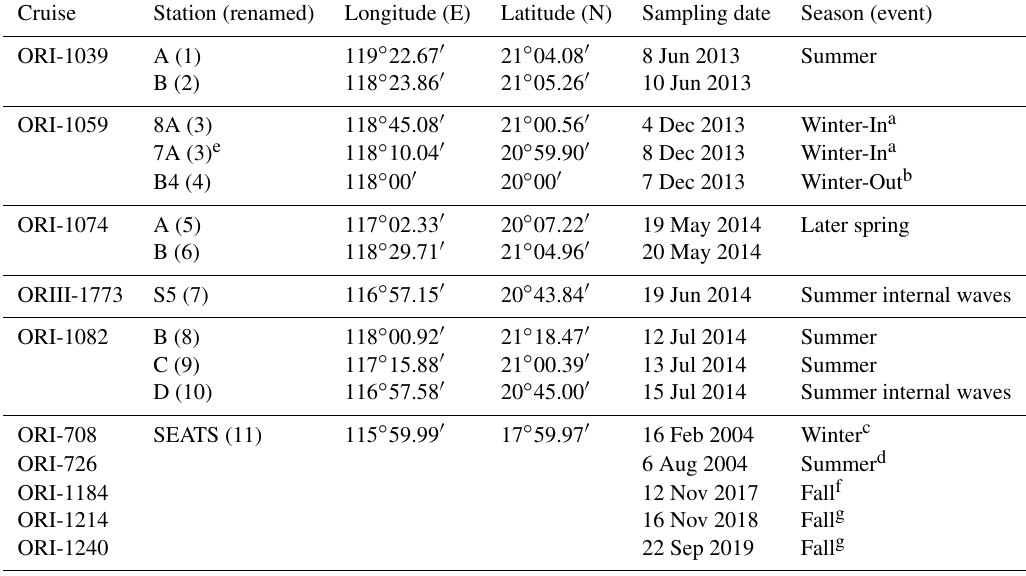
Table 1. Sampling locations and time periods during various cruises in the northern South China Sea. Sampling stations were renamed numerically, and sampling periods were also noted with the associated